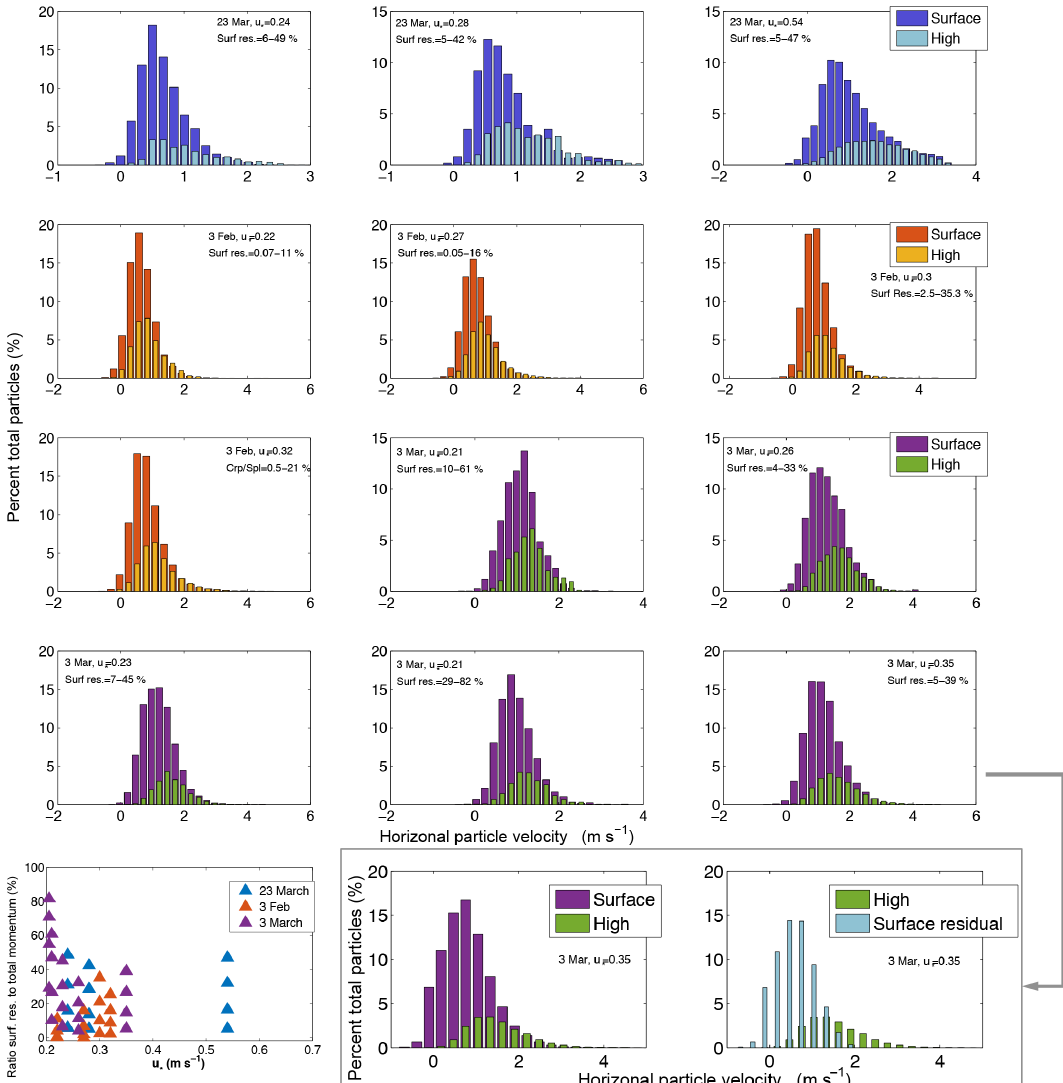
Figure 8. Horizontal particle velocity histograms for near-surface and upper-region descending particles for each recording over the three nights (each colored differently). Near-surface residual highlighted for 3 March no. 5. The two-region delineation was set at 3mm for 3 and 23 March, and 4mm for 3 February. Bottom left: surface residual to total momentum ratios for each